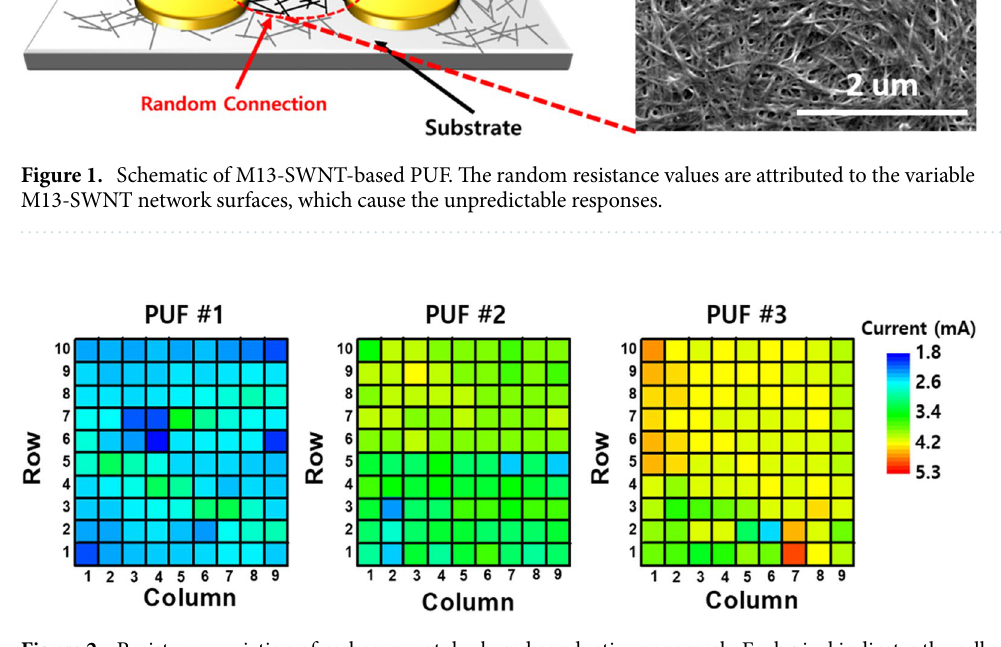
Figure 2. Resistance variation of carbon nanotube-based conductive nanomesh. Each pixel indicates the cell current value measured for 0.5 V/10 ns. All M13-SWNT based PUFs have different resistance values at the same position, indicating that they can generate different responses to the same